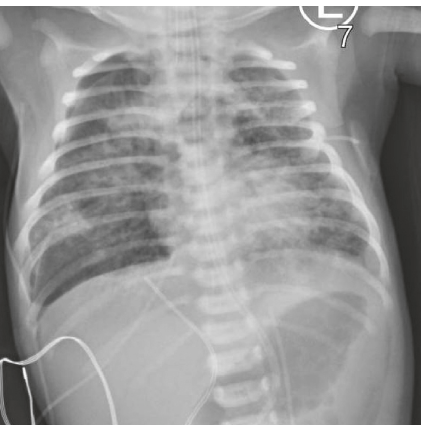
Figure 1: Chest radiograph revealing moderately sized right-sided pneumothorax and pneumomediastinum. Diffuse coarse bilateral pulmonary opacities consistent with MAS.